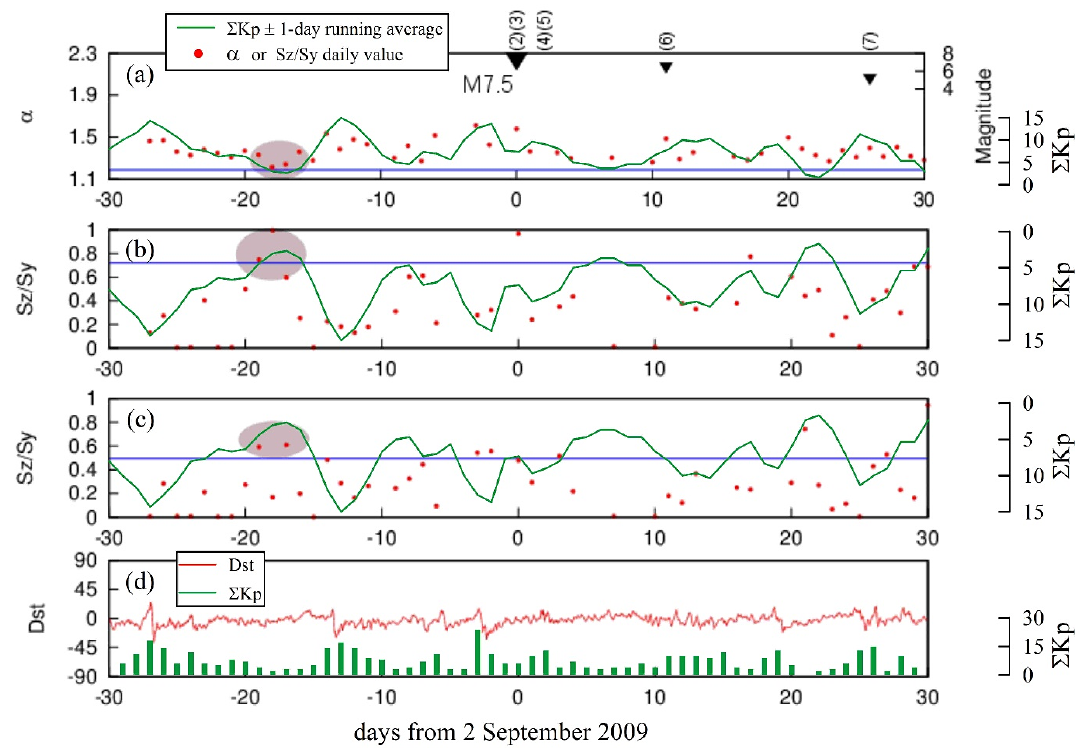
Figure 1. ULF analysis (10 ± 3mHz) at the time of the 2 September 2009 Tasikmalaya earthquake as reported by Febriani et al. (2014, Fig. 9). Day = 0 is the day of the earthquake. (a) DFA α exponent of the magnetic field vertical Z component. The horizontal blue line refers to ( α − 2 σ α ). (b, c) Spectral density ratio S Z /S Y calculated without and with the minimum energy method. The horizontal blue line